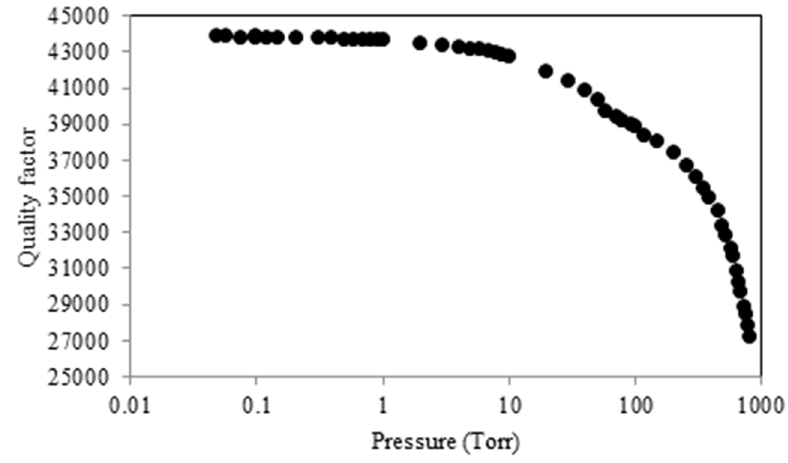
Figure 12. A typical measured Quality factor vs. pressure plot for micro-scale (MEMS) resonators.